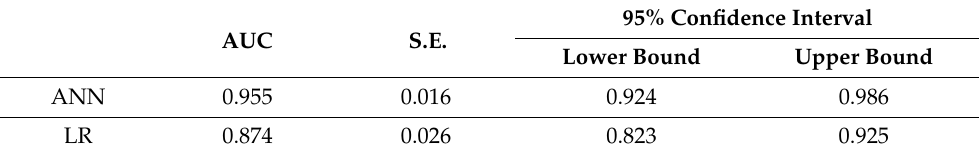
Table 5. The AUC of ANN and LR